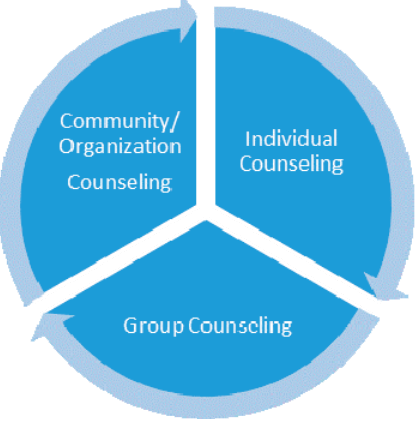
Figure 7. Application topics of community counseling .